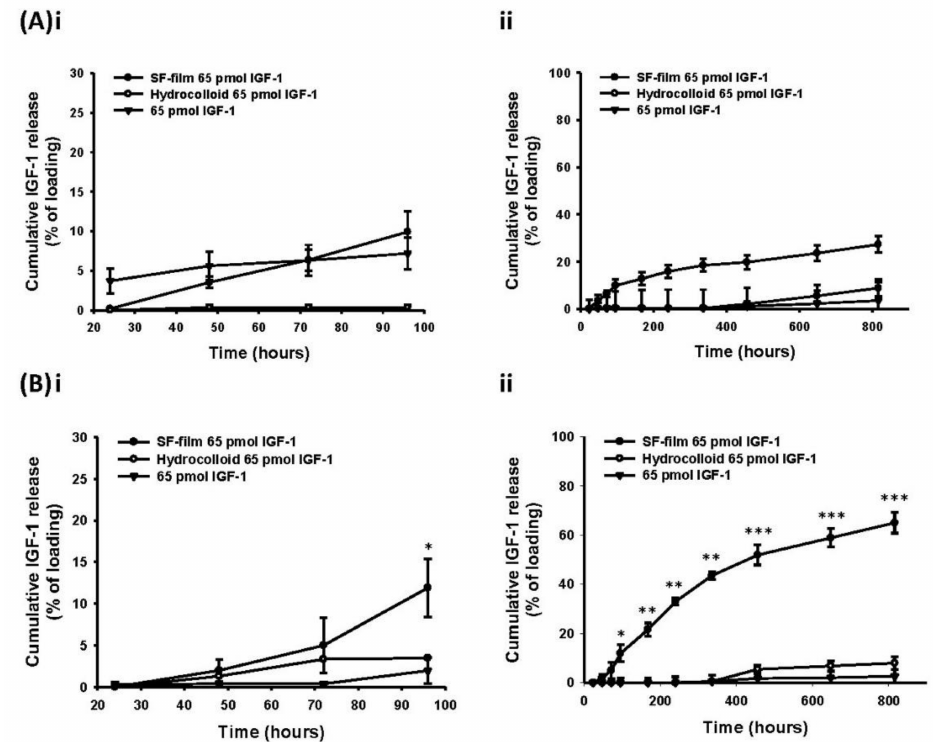
Figure 2. Release profiles of insulin-like growth factor 1 (IGF-1)-loaded silk fibroin film (IGF-1-loaded SF film), IGF-1 loaded onto SF films or hydrocolloid dressing. ( A ) The cumulative release curve of 65 pmol IGF-1 (i) from 24 to 96 h, and (ii) 24 to 816 h at 4 ◦ C. ( B ) The cumulative release curve of 65 pmol IGF-1 (i) from 24 to 96 h, and (ii) 24 to 816 h at 37 ◦ C. ( • ) SF films loaded with IGF-1; ( Hydrocolloid loaded with IGF-1; ( (cid:72) ) IGF-1 alone, * p < 0.05, ** p < 0.01, *** p < 0.001 in